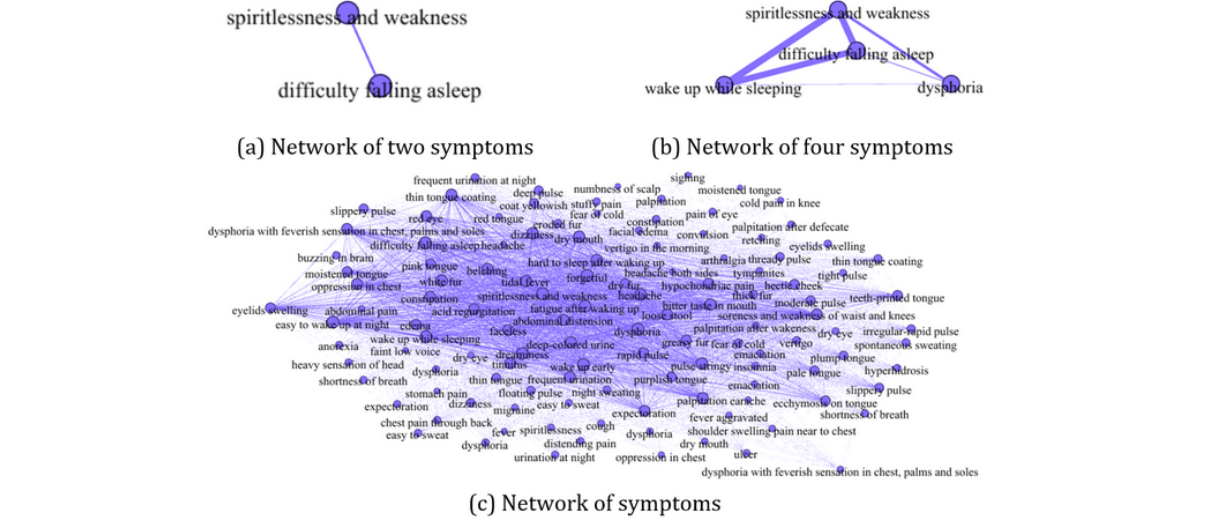
Figure 2. Construction process of the symptom